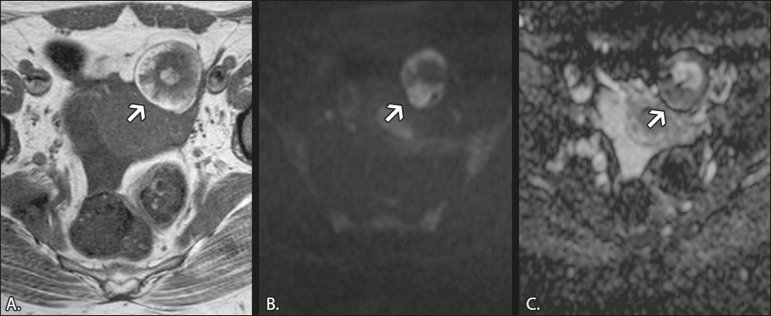
MRI of a 32-year-old female patient with a left mature cystic
teratoma. A: Axial T1W image showing a cystic
lesion with areas of high signal intensity in which the signal
became hypointense after fat saturation (not represented).
B: Axial DWI at b = 1000 s/mm2,
showing areas of high signal intensity within the lesion.
C: ADC map showing low ADCs within the
lesion.